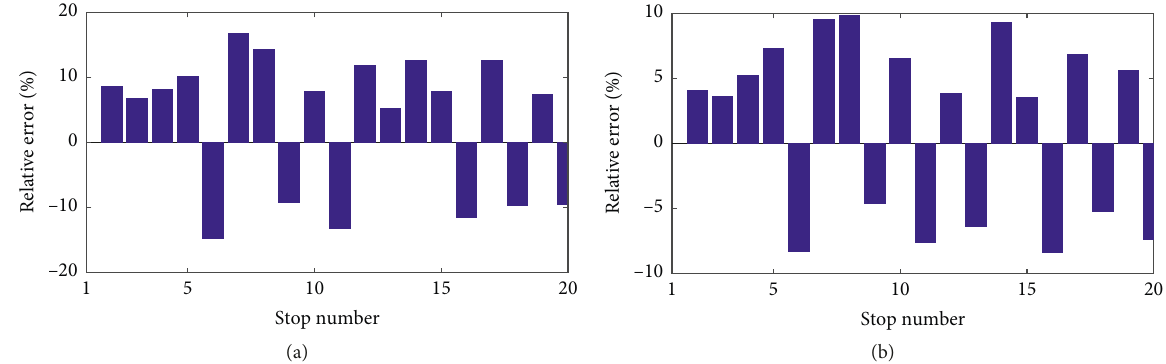
Figure 6: Relative error of predicted bus arrival time by WNN and IPSO-WNN models: (a) WNN model; (b) IPSO-WNN